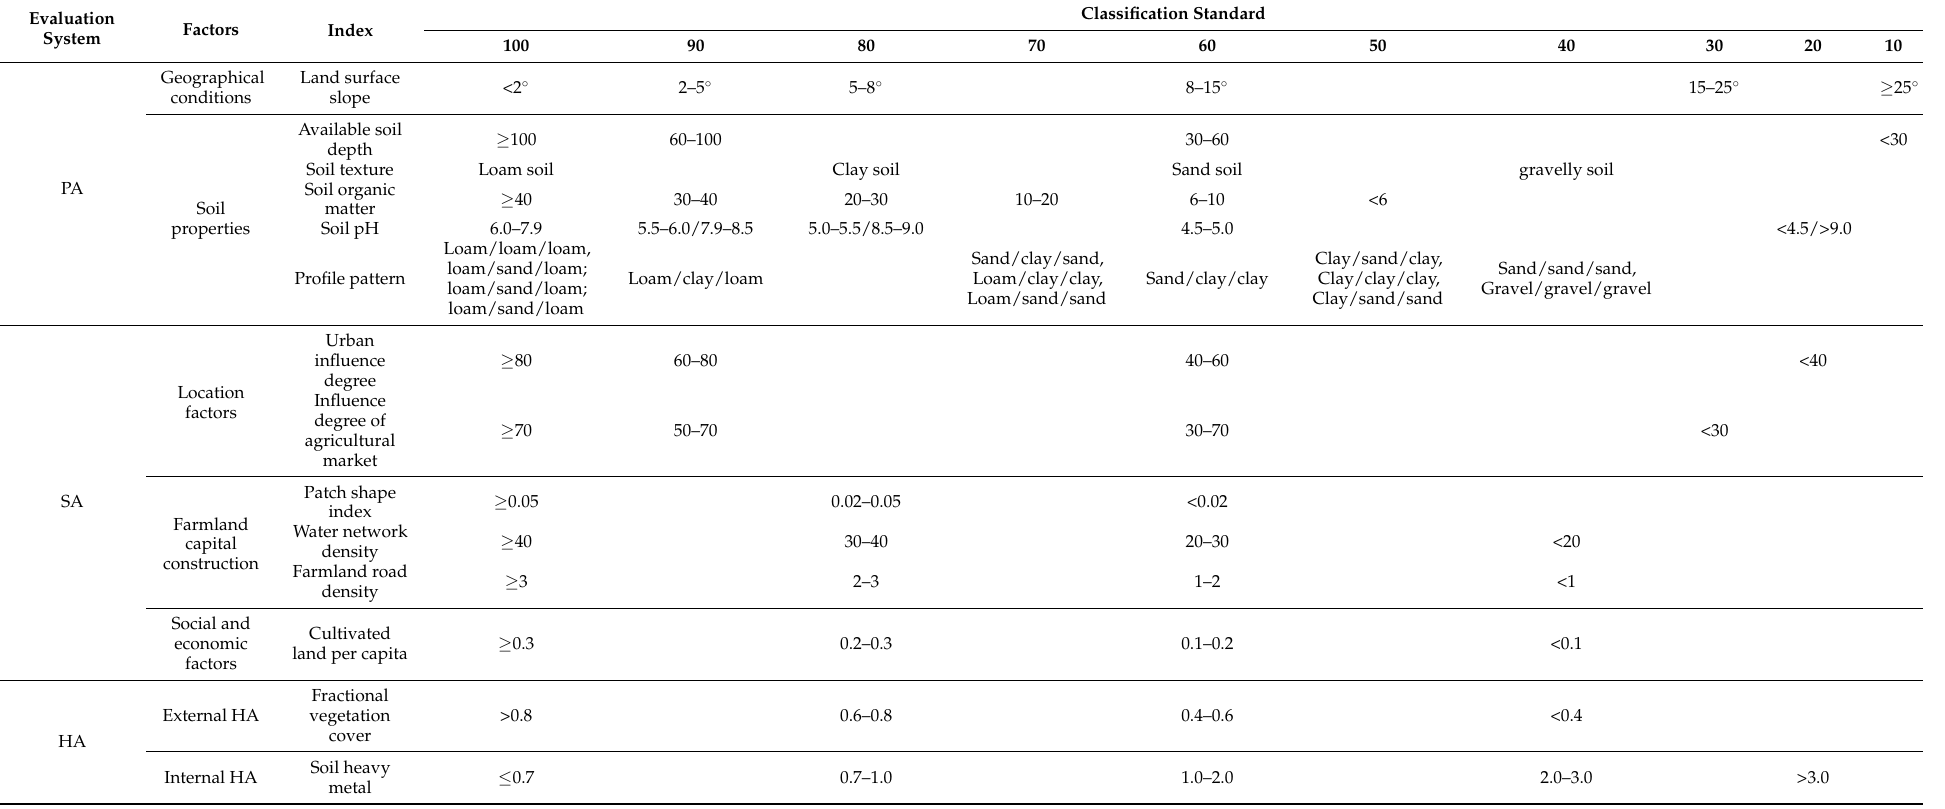
Table 2. Comprehensive evaluation indicator system and quantification standards of cultivated